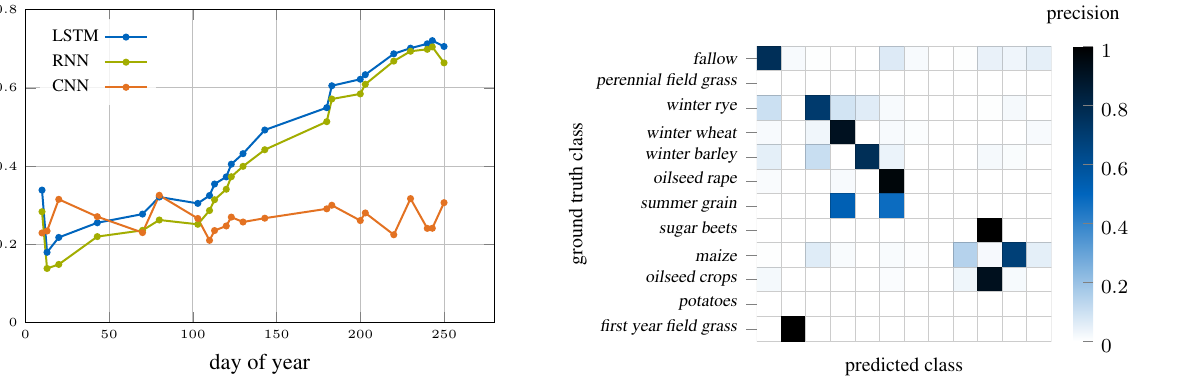
Figure 11. Confusion matrix reporting class-wise average accuracy values reported by Foerster et al.